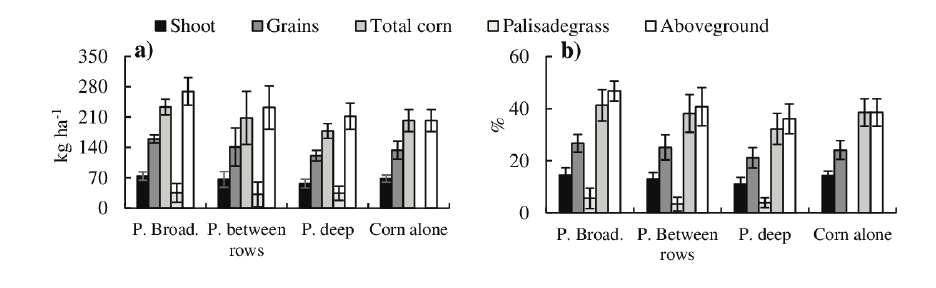
Figure 3 - Total N (a) and N fertilizer recovery (b) in the corn shoot, grains, total corn (grains + shoot), palisadegrass and aboveground (corn + palisadegrass). Bars represented the standard error of the means